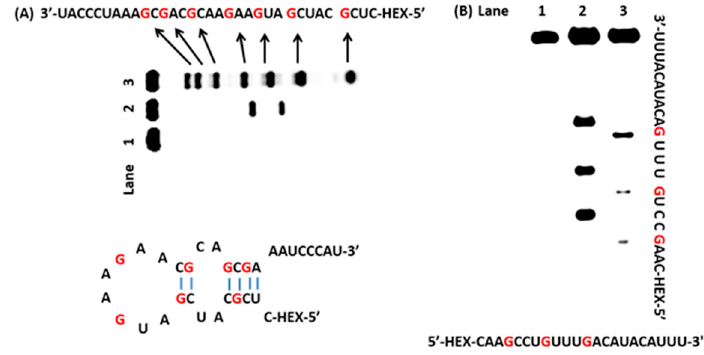
Figure 4. Polyacrylamide gel electrophoresis analysis of RNA sequences treated with AP and aniline acetate. ( A ) Lane 1: RNA alone; lane 2: RNA was treated with RNase T1; lane 3: RNA was treated with AP and aniline acetate; ( B ) Lane 1: RNA alone; lane 2: RNA was treated with AP and aniline acetate; lane 3: RNA was treated with RNase T1.